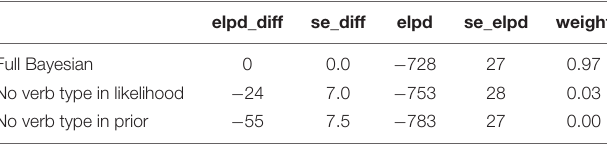
The table is ordered by the expected log-predictive density (elpd) score of the models, with a higher score indicating better predictive accuracy. The highest scoring model is used as a baseline for the difference in elpd (elpd_diff) and the difference standard error (se_diff). ‘Weight’ represents the weights of the individual models that maximize the total elpd score of all the